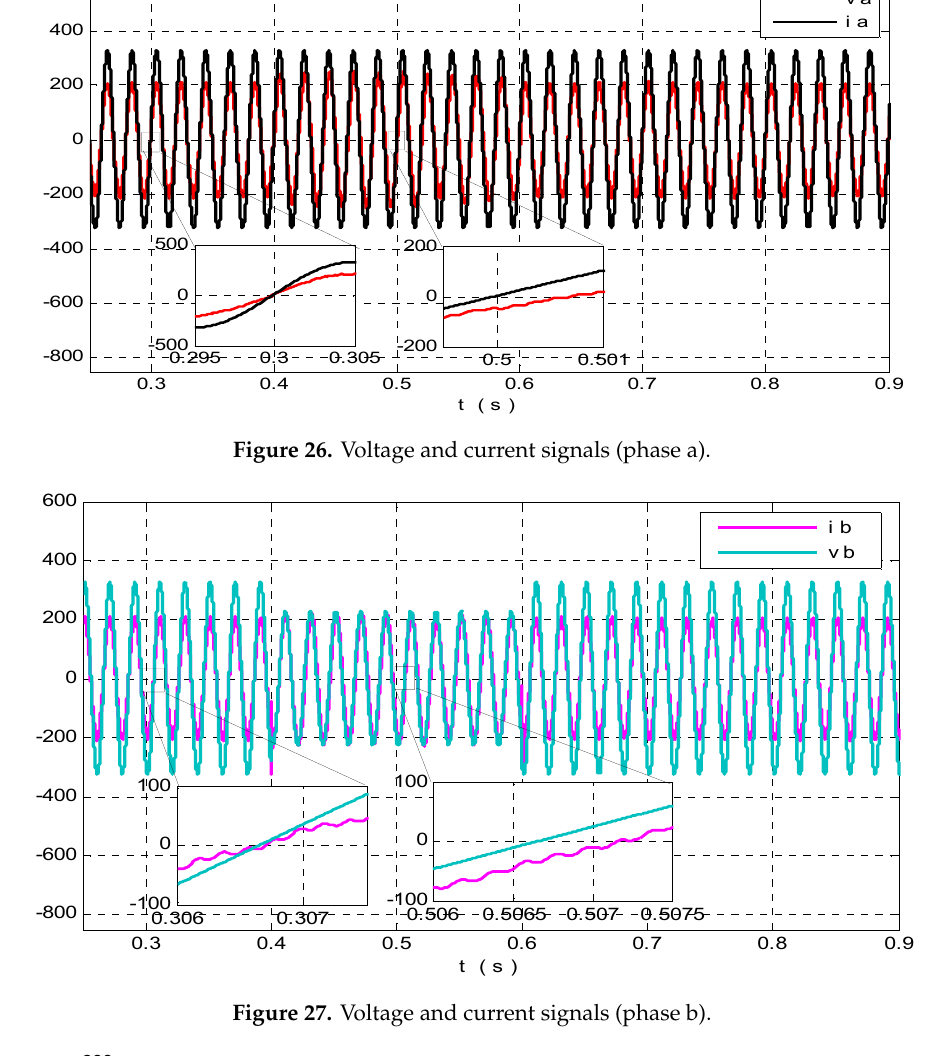
Figure 25. The grid voltage signals.